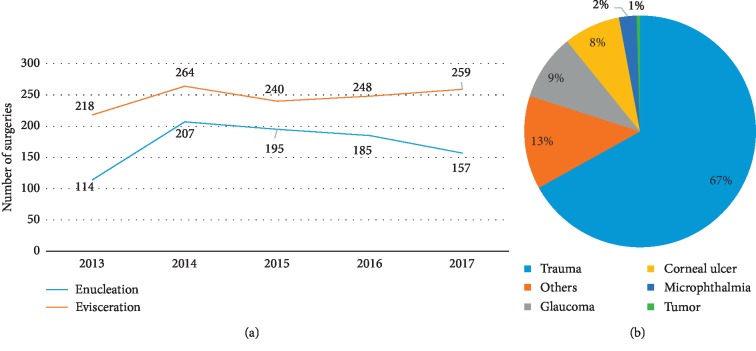
Number of eviscerations performed per year and major causes of evisceration. (a) Number of eviscerations and enucleations performed was 246 ± 18 and 286 ± 37 cases per year, respectively, between 2013 and 2017. (b) Trauma was the major cause (67%) for evisceration; glaucoma and corneal ulcer were responsible for 9% and 8% of the evisceration cases, respectively.